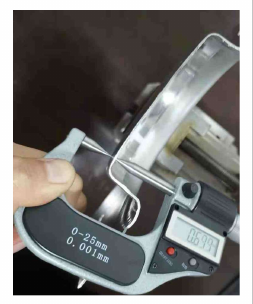
Figure 33. Thickness